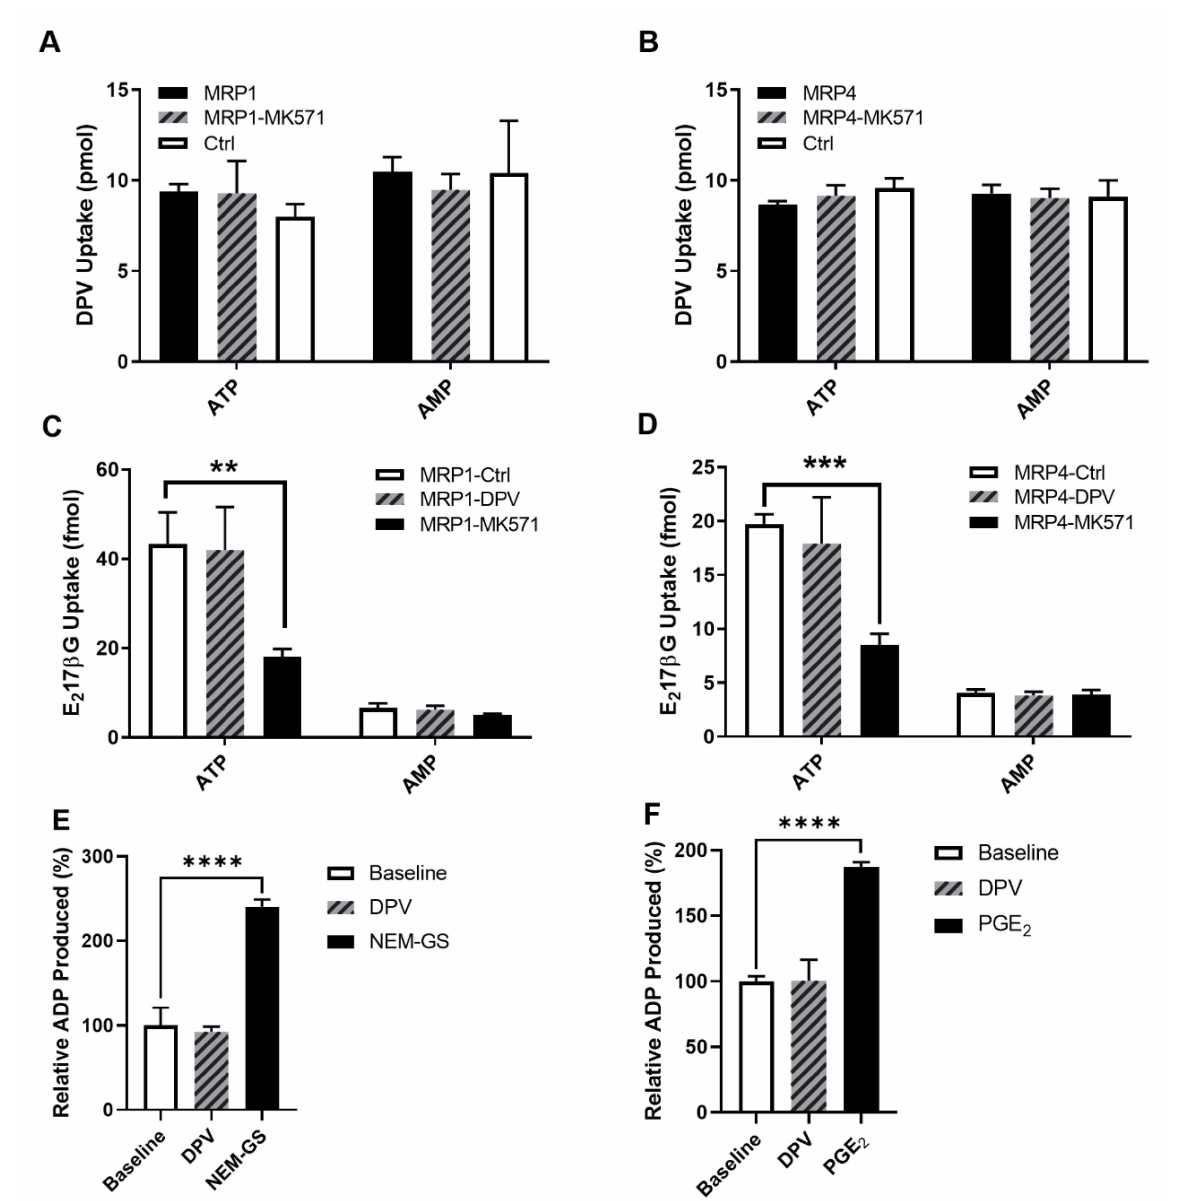
Figure 1. Vesicular uptake of DPV in MRP1 ( A ) and MRP4 ( B ) vesicles without and with MK571 and in control vesicles (ctrl); Vesicular uptake of estradiol 17 β -D-glucuronide (E 2 17 β G) in MRP1 ( C ) and MRP4 ( D ) vesicles alone (ctrl), with DPV, and with MK571; ATPase activity in MRP1 ( E ) and MRP4 ( F ) vesicles with N-ethylmaleimide-S-glutathione (NEM-GS) and prostaglandin E 2 (PGE 2 ) being the positive control substrates. Data represented as mean ± SD of three biological replicates. ** p < 0.01. *** p < 0.001. **** p < 0.0001 (Student’s t